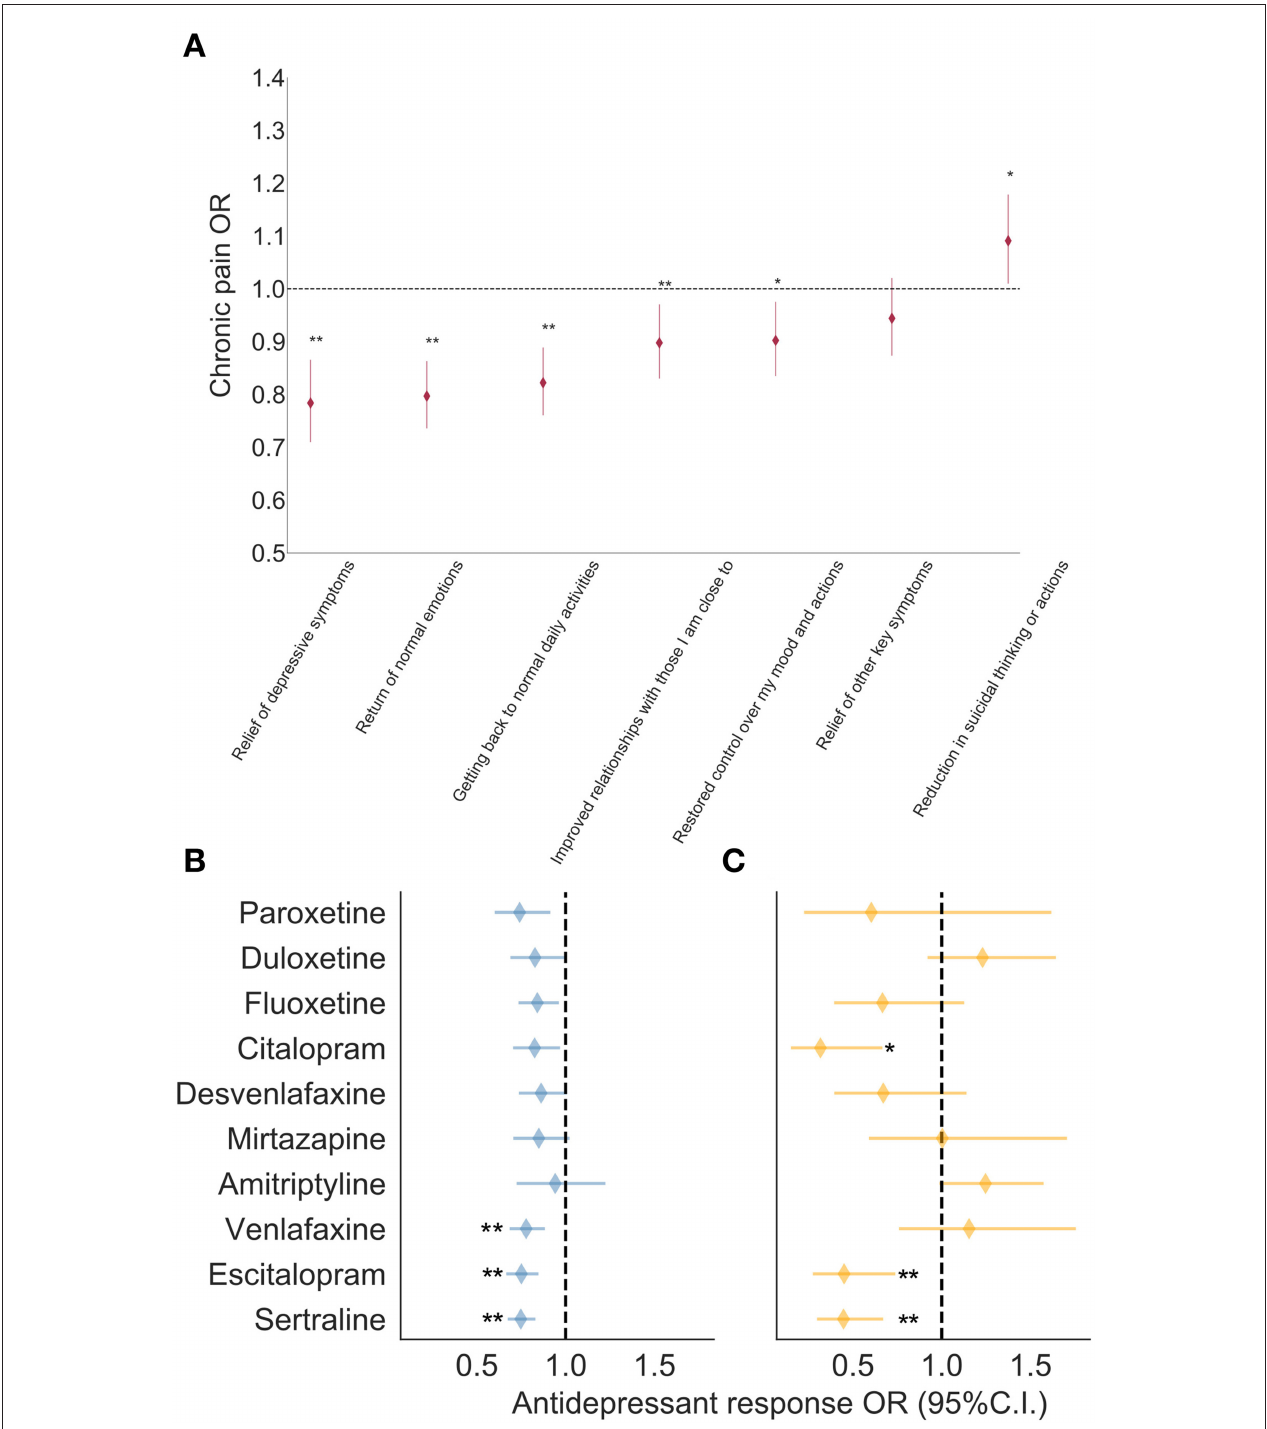
FIGURE 3 | Effect of chronic pain on antidepressant benefits in AGDS cohort. Forest plots depicting the results from: (A) association of chronic pain with self-reported benefits from general antidepressant treatment; and associations between antidepressant treatment response and (B) self-reported chronic pain or (C) self-reported prescription for chronic pain, while adjusting for the effects of sex and age at commencement of taking the antidepressant (* p < 0.05; ** p < 0.005 statistical significance after Bonferroni correction for multiple testing; AGDS data only). Further details are in Supplementary Figure 4 and Supplementary Tables 4 , 5 .